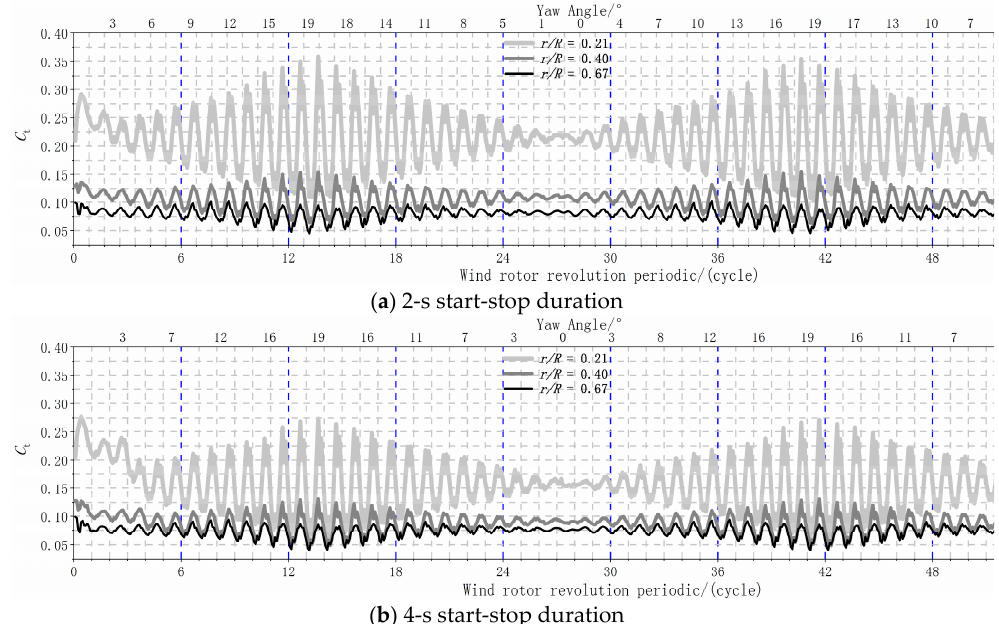
Figure 28. Comparison of C t under di ff erent start-stop durations for three di ff erent spanwise sections under dynamic